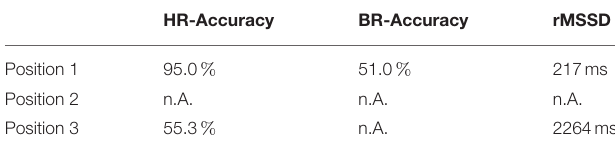
TABLE 3 | Subject 3: Accuracy of HR and BR.